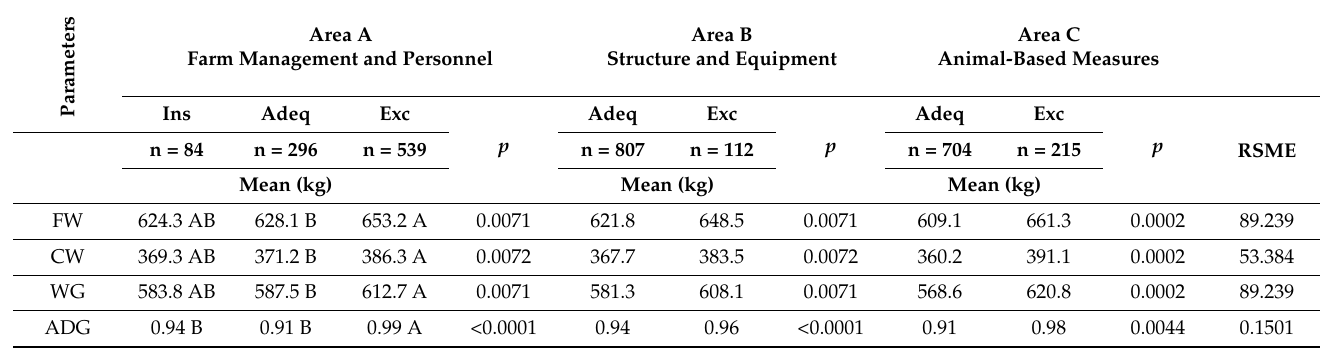
Table 6. Influence of each area on the FW, CW, WG, and